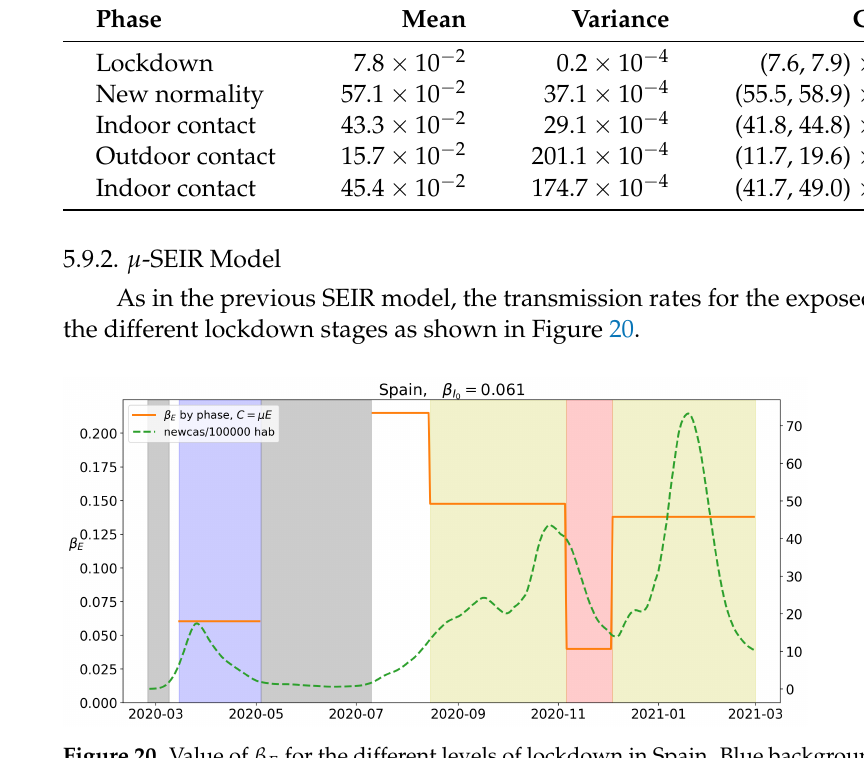
Figure 20. Value of β E for the different levels of lockdown in Spain. Blue background will correspond to Stage 1, red to Stage 2, yellow to Stage 3 and white to Stage 4. A green dotted line corresponds to the value of new cases per 100,000 hab.